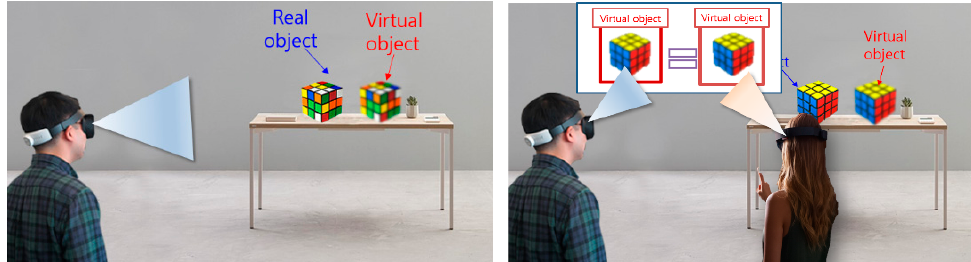
Figure 1. A user’s perception in a mixed reality (MR) environment. When comparing a virtual object with a real object in an MR environment, the user must be able to perceive the scale and color using different MR devices ( left ). Additionally, the user should be able to recognize the same size and color, irrespective of the MR device worn ( right ). In our case, we assumed that people wearing different MR devices had different perceptions.